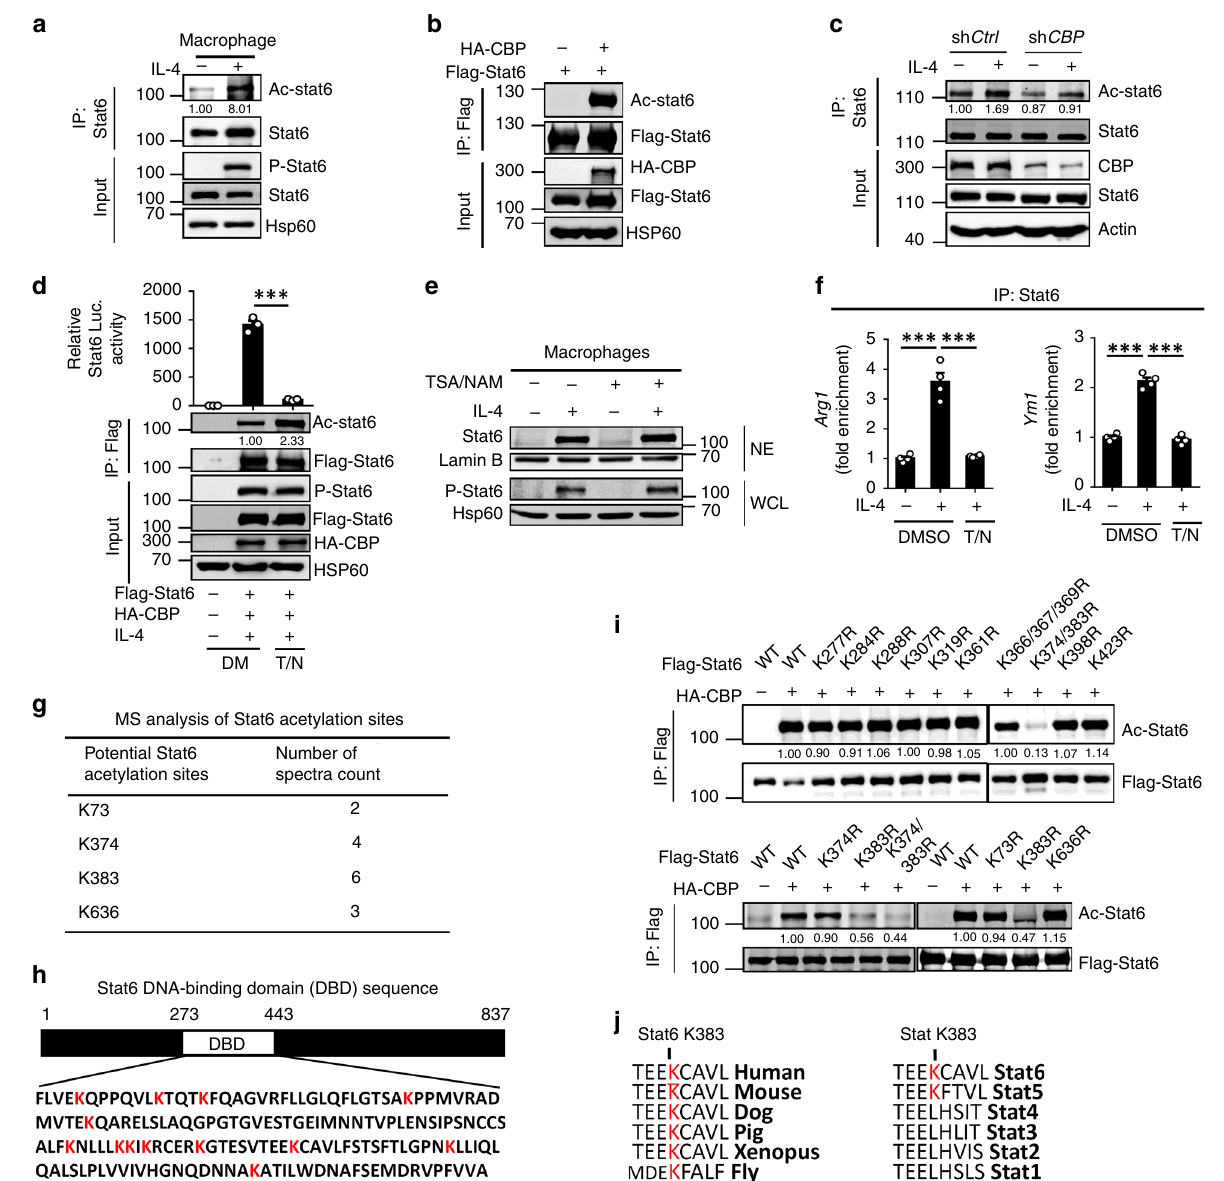
Fig. 1 Stat6 is acetylated at Lys383. a – c Immunoblot analysis of the lysine acetylation of Stat6 in primary murine macrophages ( a ) or 293T cells transfected with the indicated expression vectors ( b ), or in control and CBP -knockdown iBMDMs ( c ) that were ( + ) or were not ( − ) stimulated with IL-4 for 30 min; lysates were assessed by immunoprecipitation (IP) with anti-Stat6 or anti-Flag and immunoblotting with anti-Ac-Lys and anti-Stat6, or anti-Flag, and immunoblot of the lysates to detect input proteins and loading controls. d Luciferase assay showing Stat6 transcriptional activity in 293T cells transfected with the indicated vector that were pretreated with DMSO (DM) or trichostatin A (TSA, 5 μ M) plus nicotinamide (NAM, 1 mM) (T/N) and then stimulated with ( + ) or without ( − ) IL-4 for 4 h before detection. Lysates were immunoblotted for acetylated (Ac − ), phosphorylated (P − ) Stat6, HA, Flag, and Hsp60 as controls. e , f Immunoblot of Stat6 and Lamin B in nuclear extracts and phosphorylated (P)-Stat6 and Hsp60 in whole-cell lysates ( e ) and ChIP – QPCR analysis of Stat6 binding to the promoters of Arg1 or Ym1 ( f ) in murine primary macrophages that were pretreated with DMSO or TSA plus NAM (T/N) and then stimulated with ( + ) or without ( − ) IL-4 for 1 h. g Mass spectrometry analysis showing potential acetylation sites in Stat6 after the immunoprecipitation of Stat6 in 293T cells transfected with Stat6 and CBP. h Schematic representation of the mouse Stat6 protein showing the DNA- binding domain (DBD) and its amino acid sequence with all lysine (K) residues highlighted in red. i Immunoblot analysis of the lysine acetylation of wild- type (WT) and KR mutant Stat6 in 293T cells transfected with the indicated expression vectors; lysates were assessed by immunoprecipitation (IP) with anti-Flag and immunoblotting with anti-Ac-Lys and anti-Flag. j Amino acid sequence alignment of Stat6 among the indicated species and different mouse STAT proteins showing Lys383 that are highlighted in red. Data with error bars are represented as mean ± SD. Each panel is a representative experiment of at least three independent biological replicates. ∗ p < 0.05, ∗∗ p < 0.01, ∗∗∗ p < 0.001 as determined by the unpaired Student ’ s t test. Source data are provided as a Source Data fi